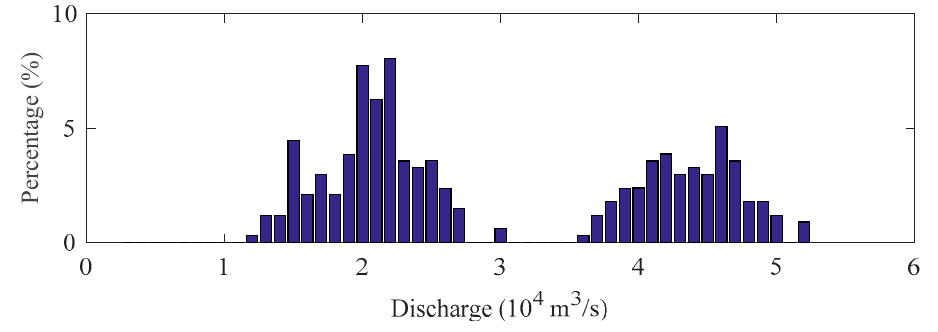
Figure 4. Frequency diagram of flow discharge statistics in the month of splitting.